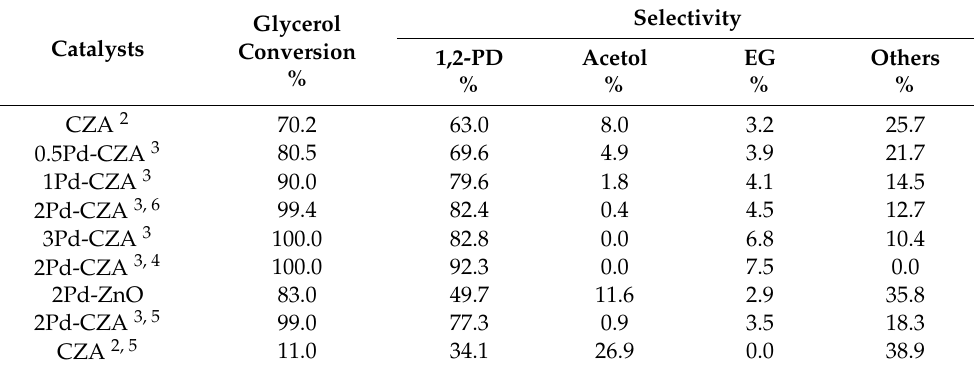
Table 2. Effect of Pd loading on the CZA catalytic activity for glycerol hydrogenolysis with in situ hydrogen from methanol steam reforming 1